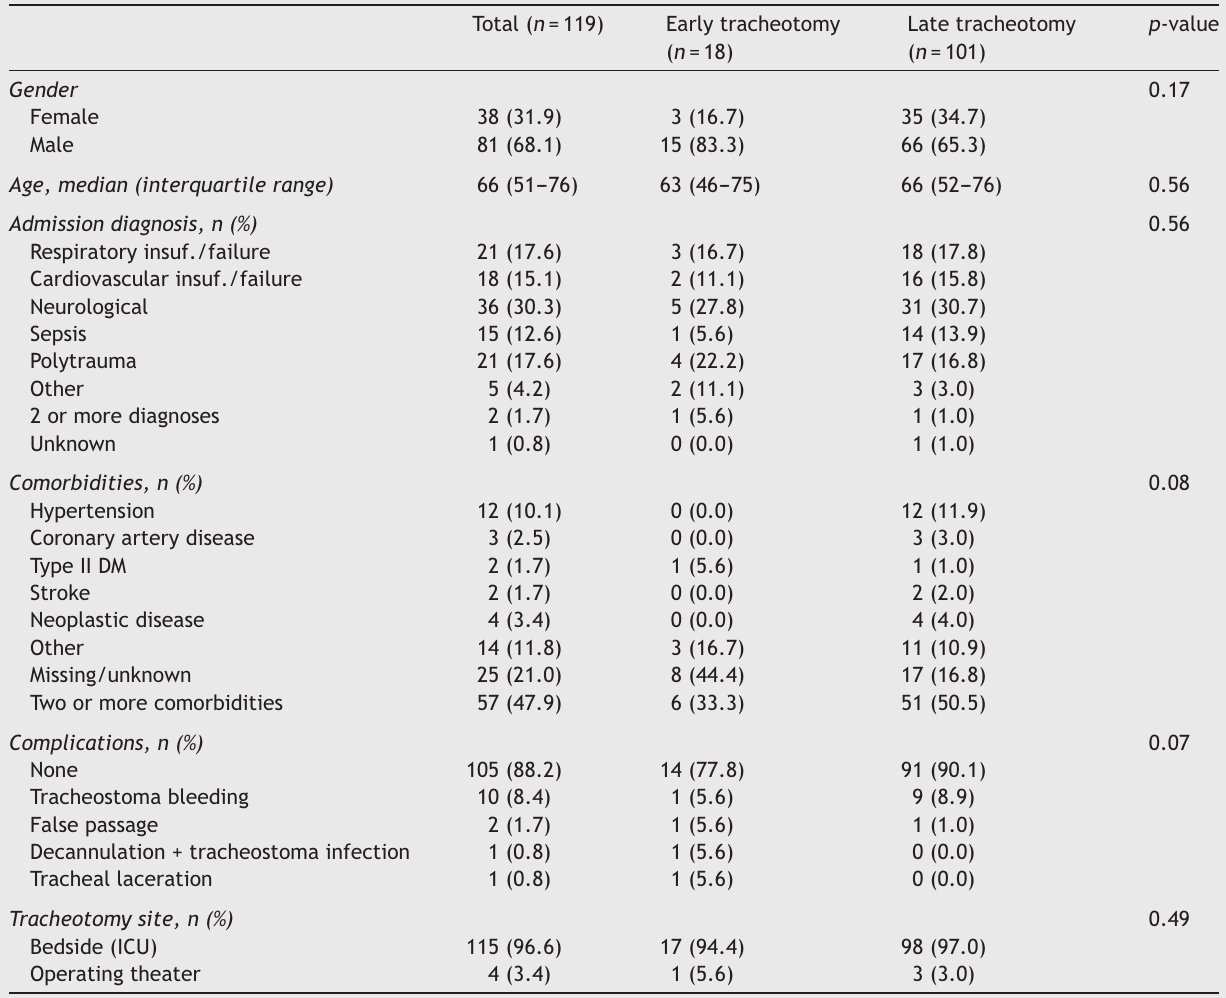
Characteristics of patients, complications, and site of the tracheotomy.